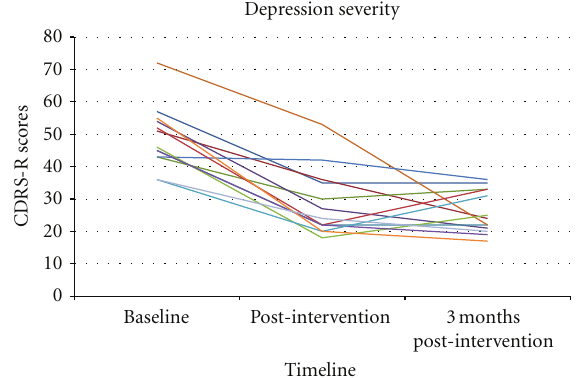
Figure 2: Children’s Depression Rating Scale scores at baseline, post-intervention and three-month post-intervention time